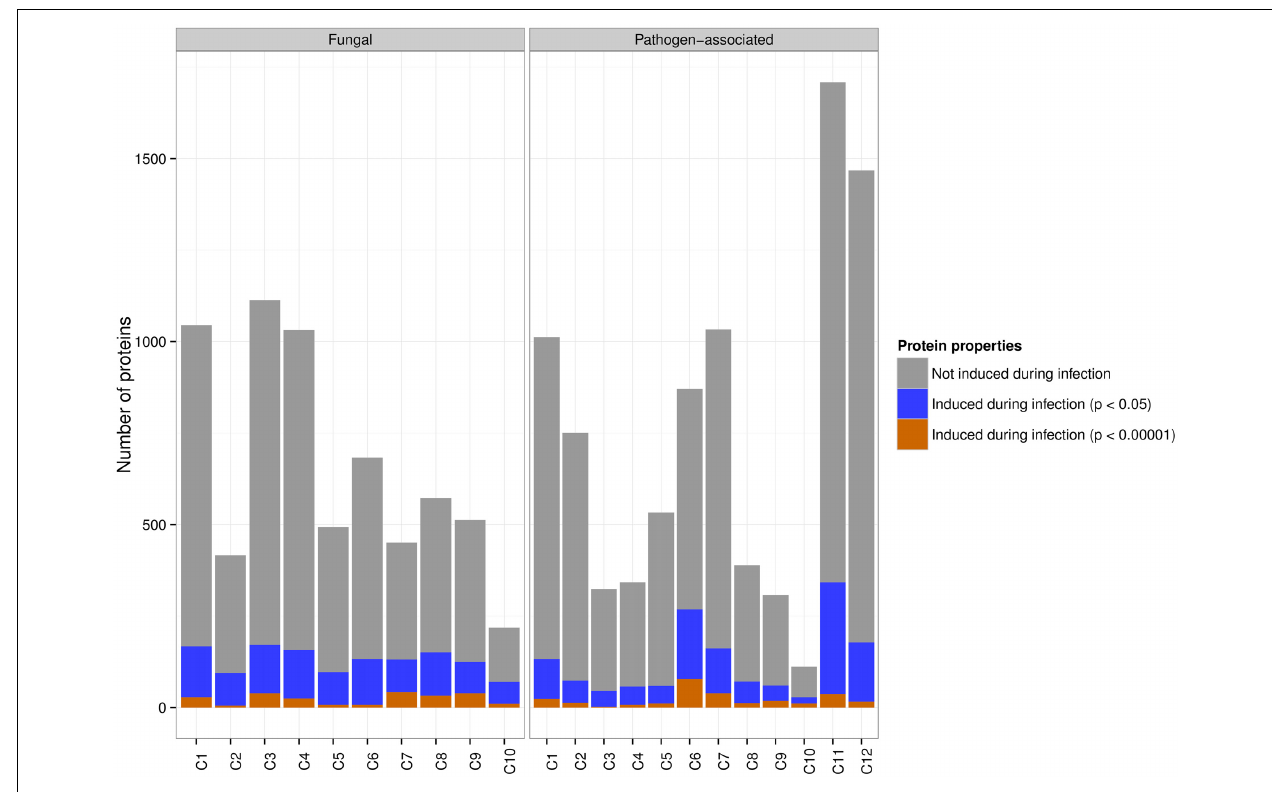
FIGURE 2 | Both fungal and pathogen-associated wheat stem rust gene families are in planta induced. The majority of pathogen-associated and fungal genes are not up-regulated during infection. At a significance threshold of p < 0 . 05, 19.8% of genes from fungal gene families are up-regulated during infection and are